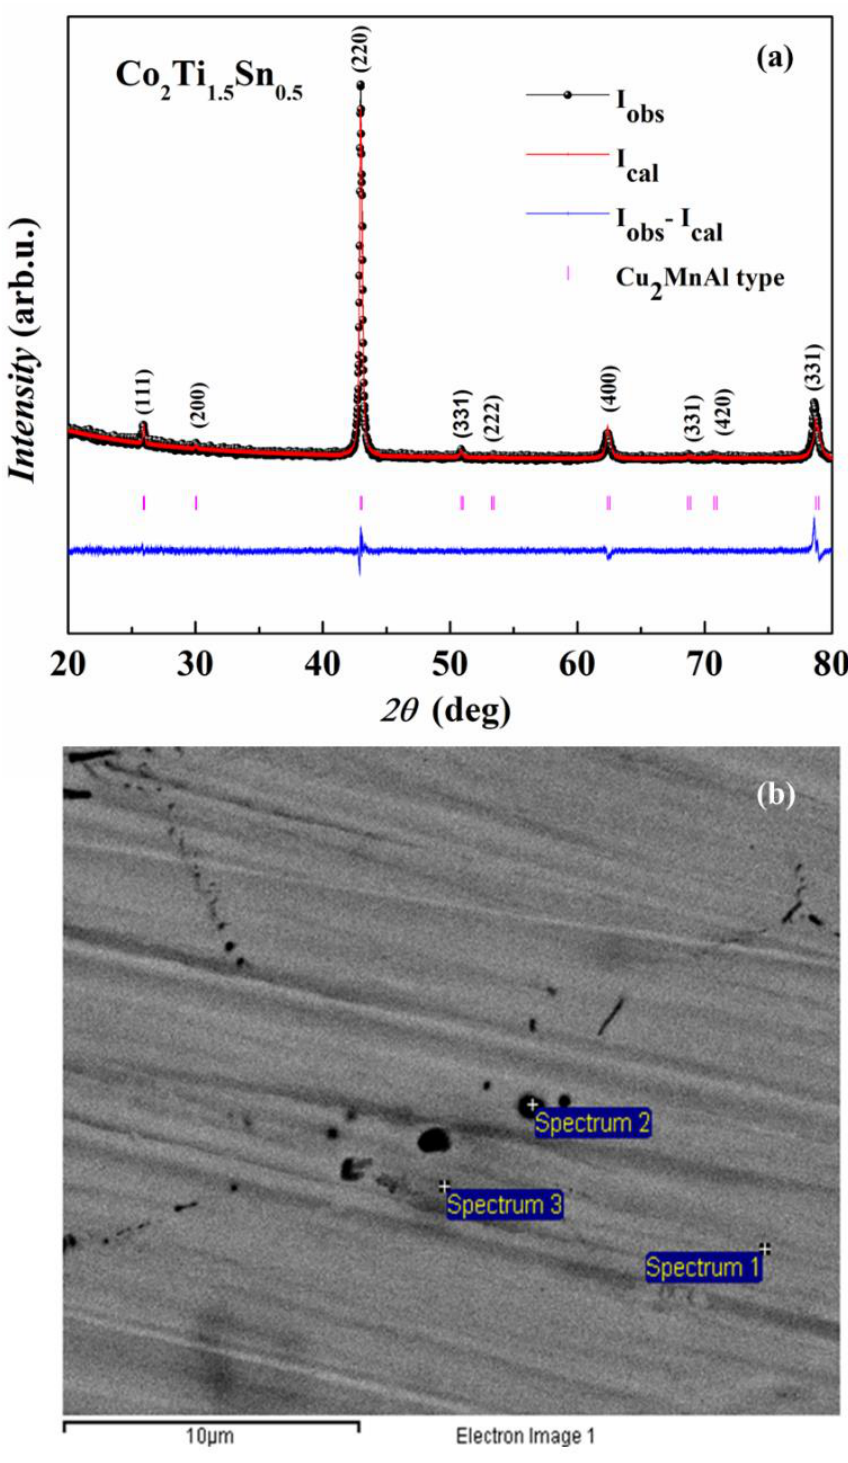
Figure 1. ( a ). Rietveld refined room temperature XRD pattern of Co 2 Ti 1.5 Sn 0.5 . ( b ) BSE image of Co 2 Ti 1.5 Sn 0.5 alloy. Co 2 Ti 1.5 Sn 0.5